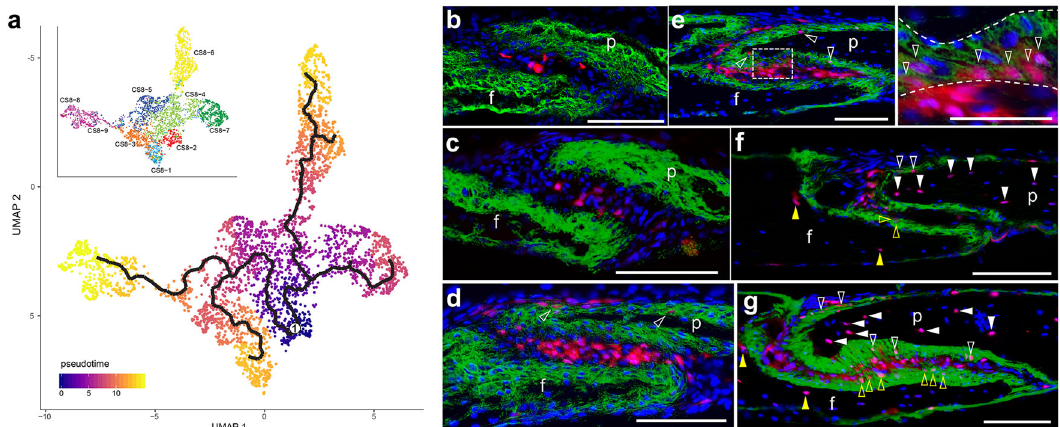
Fig. 4 Fate mapping of Hhip -CreERT2-expressing suture mesenchyme. a Graph abstraction of the relationships between CS8-1 to CS8-9. Inset shows coloring by cluster identity. The root state of the inferred trajectory is indicated by the number 1 at the center of the cells with the earliest pseudotime. b TdTomato-expressing (tdTomato + ) cells at postnatal day (P)2 after 1 day of induction. n = 3. c TdTomato + cells at P3 after two consecutive days of induction. n = 3. d TdTomato + cells at P6 after fi ve consecutive days of induction. n = 1. e TdTomato + cells at P30 after 1 day of induction at P1. Dashed box is enlarged at right to show cluster of tdTomato + osteoblasts within ALPL domain (dashed lines). n = 1. f TdTomato + cells at P90 after two consecutive days of induction at P1 and P2. n = 3. g TdTomato + cells at P90 after fi ve consecutive days of induction between P1-P5. n = 2. White and yellow empty/solid arrowheads indicate tdTomato + osteoblasts/osteocytes in parietal and frontal bones, respectively. f frontal bone, p parietal bone. Sections are in the sagittal plane. Scale bars, 100 μ m except inset in e , 50 μ